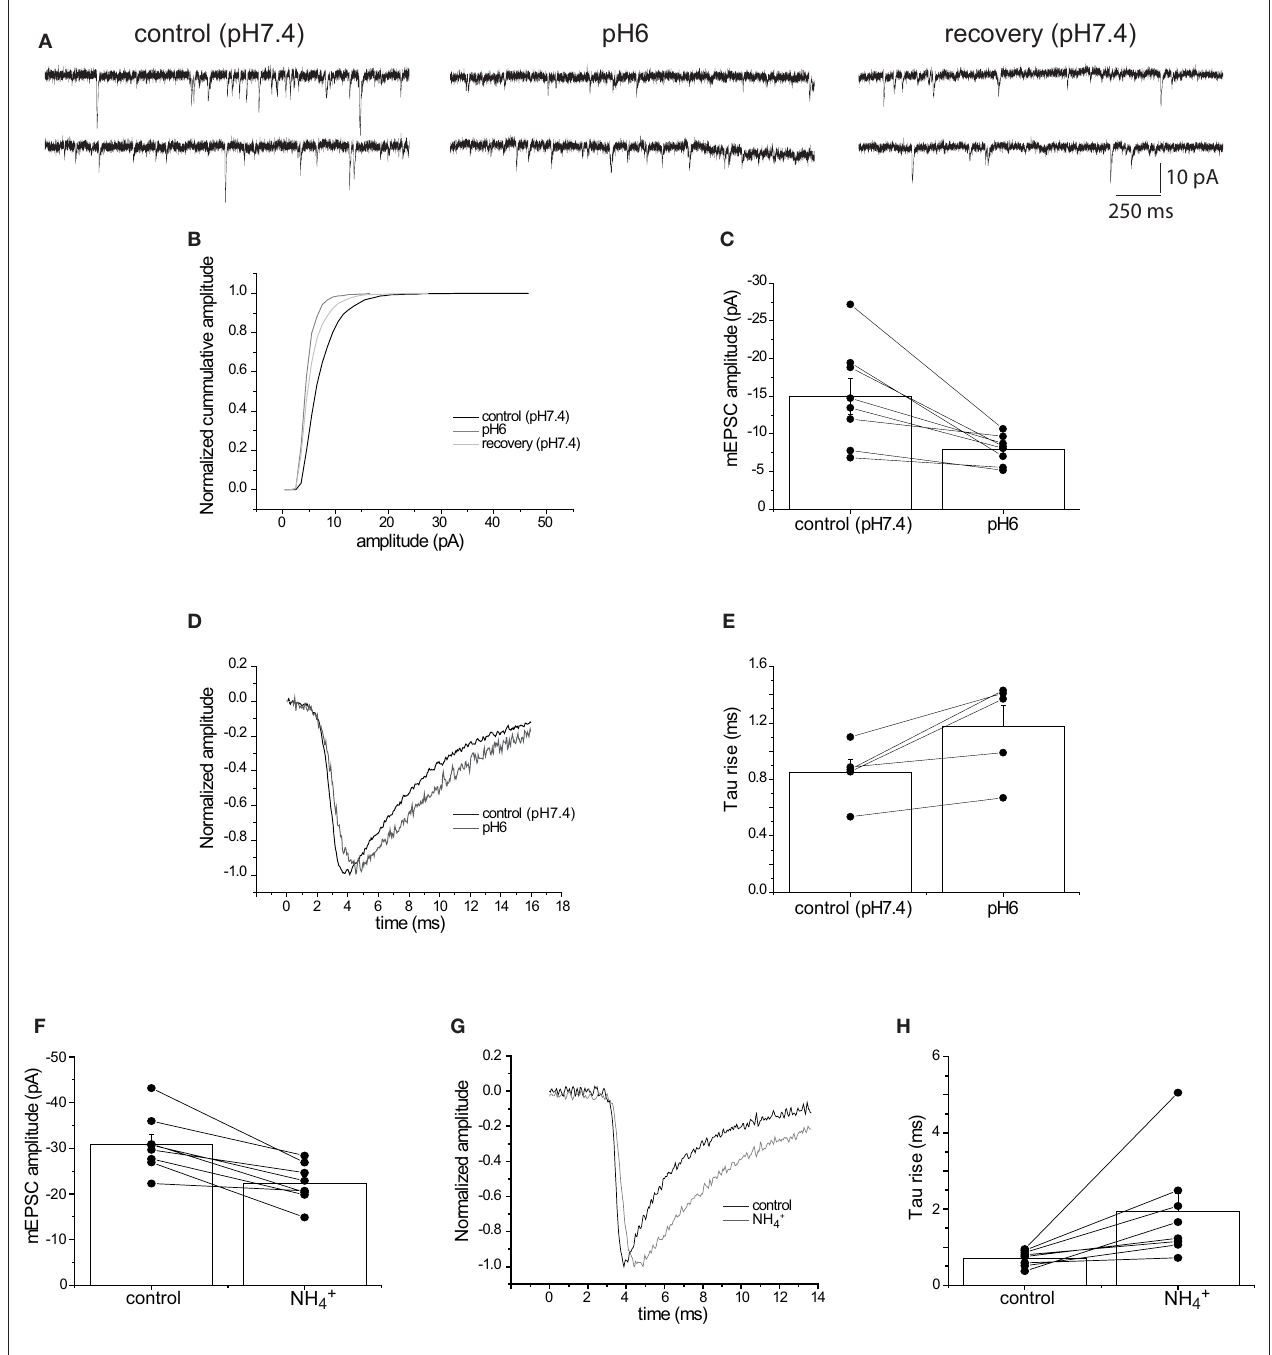
Figure 4 | extracellular pH6 reversibly reduces the amplitude of spontaneous miniature ePSCs. (A) . Sample current traces showing miniature EPSCs (mEPSC) before and after application of pH6 extracellular solution, showing a clear reduction of amplitude of the spontaneous events. (B) Cumulative amplitude plot for the experiment shown in (A) Application of pH6 extracellular solution reduces mEPSC amplitude, an effect that is partially reversible. (C) Meaned ( ± sem , n = 8) mEPSC amplitude before and after application of pH6 extracellular solution. Amplitudes from individual cells are shown in a combined line series plot. (D) Normalized mEPSC waveforms from a single cell before and after the application of pH6 extracellular solution, showing